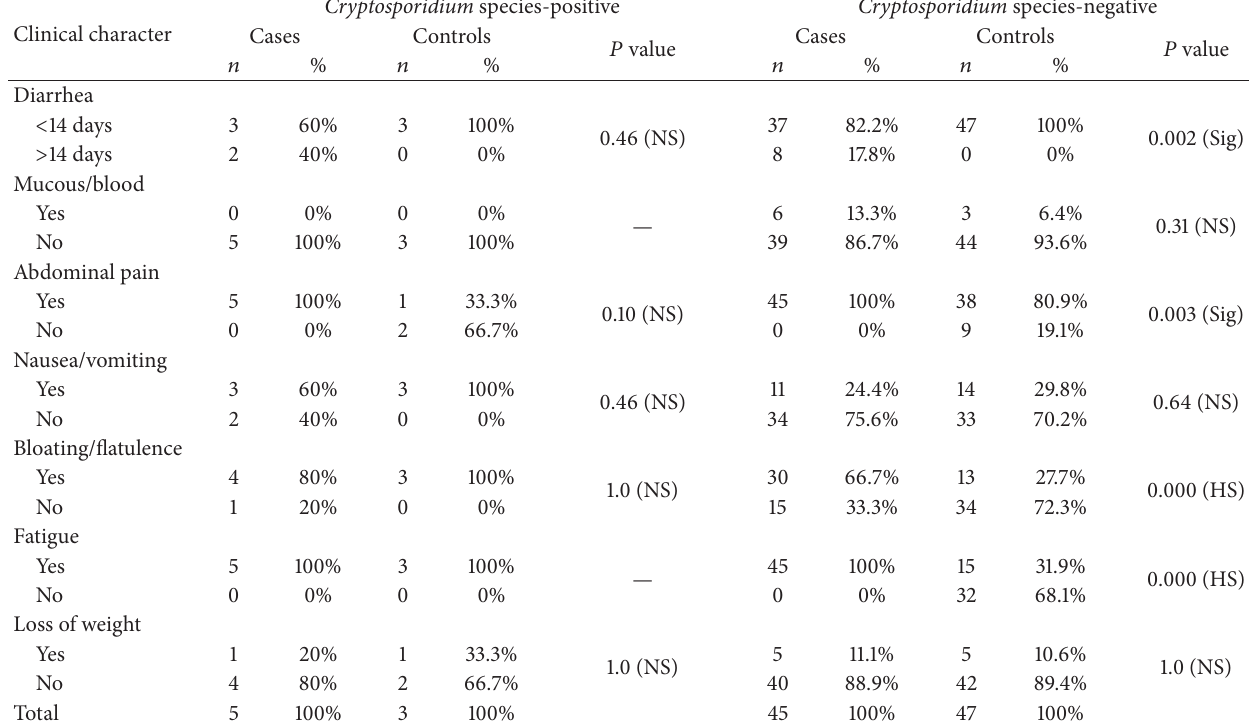
Table 4: The clinical characteristics variations among Cryptosporidium species positive/negative diarrheal cases and controls. Clinical character